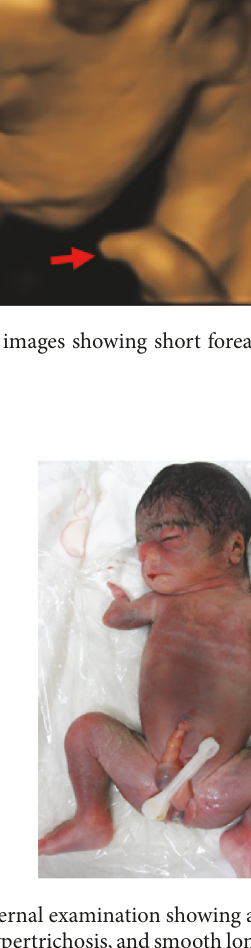
Figure 2: FetalMRI at26 weeks of gestation showing shortforearms and hypoplasty of hand fingers.